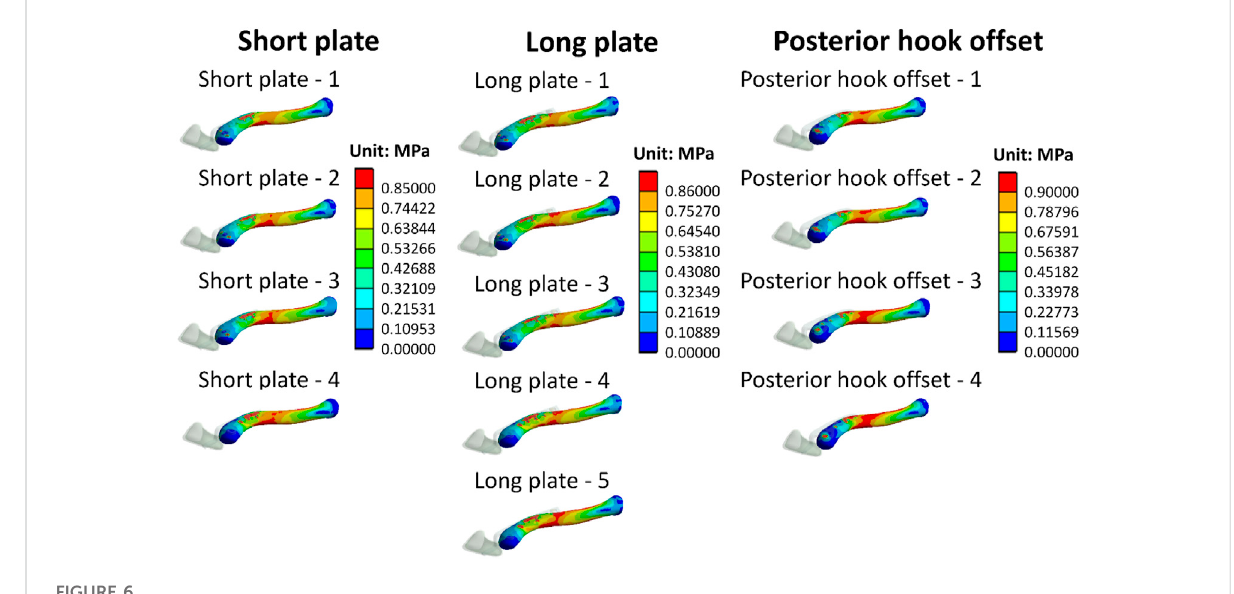
FIGURE 6 Stress distribution of clavicles.